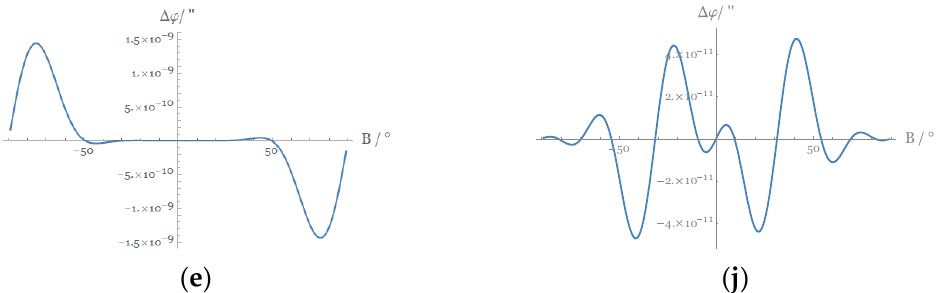
Figure 1. The calculation error of the derived expressions (geodetic latitude as the variable). ( a ) Calculation error ∆ φ ( B ) of geocentric latitude (expanded to e 10 ). ( b ) Calculation error ∆ u ( B ) of reduced latitude (expanded to e 10 ). ( c ) Calculation error ∆ ψ ( B ) of rectifying latitude (expanded to e 10 ). ( d ) Calculation error ∆ ϑ ( B ) of authalic latitude (expanded to e 10 ). ( e ) Calculation error ∆ ϕ ( B ) of conformal latitude (expanded to e 10 ). ( f ) Calculation error ∆ φ ( B ) of geocentric latitude (expanded to n 5 ). ( g ) Calculation error ∆ u ( B ) of reduced latitude (expanded to n 5 ). ( h ) Calculation error ∆ ψ ( B ) of rectifying latitude (expanded to n 5 ). ( i ) Calculation error ∆ ϑ ( B ) of rectifying latitude (expanded to n 5 ). ( j ) Calculation error ∆ ϕ ( B ) of conformal latitude (expanded to n 5 ).